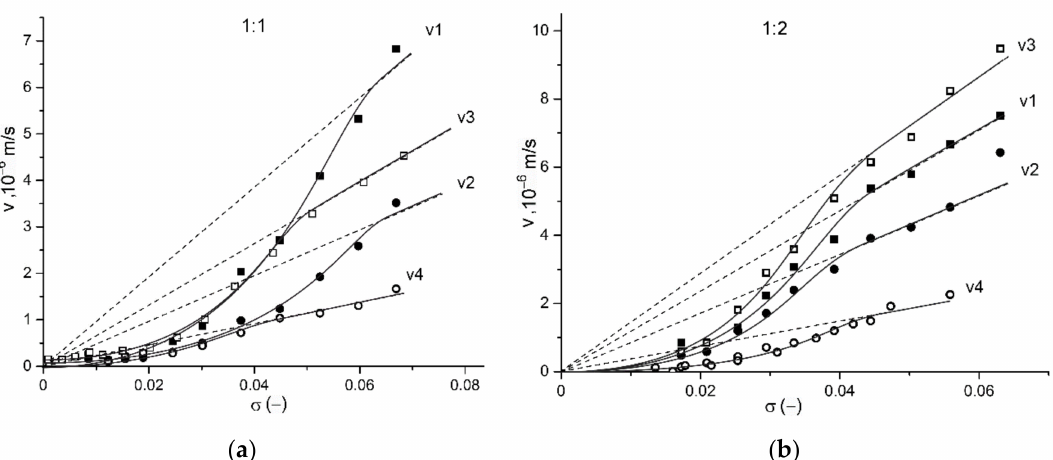
Figure 5. Step velocities of the sectors of growth hillocks on the (110) face in solutions ( a ) 1:1 and ( b ) 1:2 as a function of supersaturation. Relative error of finding values of v i did not exceed